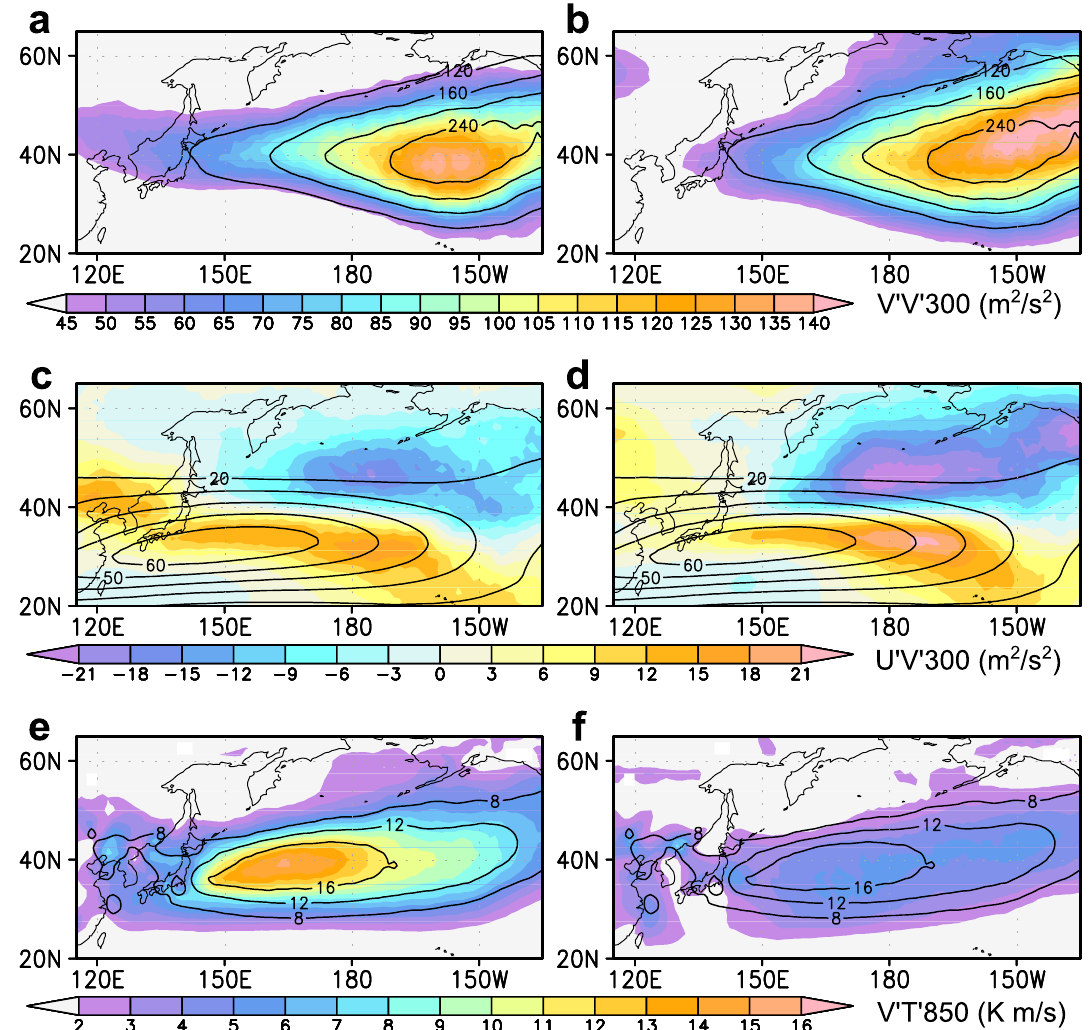
Figure 2. Separated contributions from cyclonic and anticyclonic vortices to Eulerian statistics. a–b , Contributions to climatological-mean V’V’300 (m 2 /s 2 , colors) separately from cyclonic ( a ) and anticyclonic ( b ) vortices over the midwinter (24Jan) North Pacific. Contours denote climatological-mean total V’V’300 from all vortices. c-d , Same as in Figs. 2a–b, respectively, but for U’V’300 (m 2 /s 2 , colors). Contours denote climatological-mean U300 (m/s). e–f , Same as in Figs. 2a–b, respectively, but for heat flux V’T’850 (K m/s). Contours denote climatological-mean total V’T’850 (K m/s) from all north of ~ 40°N and the poleward flux to its south. These converging fluxes thus act to accelerate the westerlies to the north and downstream of the prominent jet core around [32°N, 150°E]. The momentum flux diverges northward out of the jet core region, characteristic of a thermally driven subtropical jet 22,23 . Lower-tropospheric poleward eddy heat flux (V’T’850) by cyclonic vortices (Fig. 2e) is more than twice as strong as its anticyclonic counterpart (Fig. 2f), indicative of the prominent contribution from baroclinic cyclonic vortices to heat transport. shown in Supplementary Fig. S4, with the threshold curvature equivalent to the radius of curvature of 2500 km. As expected, the probability decreases substantially for the two polarities, but the spatial distribution overall westerly jet, for example, the probability for both cyclonic and anticyclonic vortices is very low. This is probably because the prominent westerly jet, especially in its core region, is likely to flow steadily and barely meanders to form vortices with small radii. Contributions to the Eulerian statistics are qualitatively similar to those with zero curvature threshold, but with more striking distinctions between cyclonic and anticyclonic V’T’850 (Sup- plementary Fig. S5), highlighting the dominant poleward heat flux concentrated around cyclone centers, as inferred from a typical structure of extratropical cyclones 24 . The aforementioned characteristics of the contribution from anticyclonic vortices to the Eulerian statistics revealed with curvature, including comparable or even slightly stronger V’V’300, greater U’V’300, and weaker